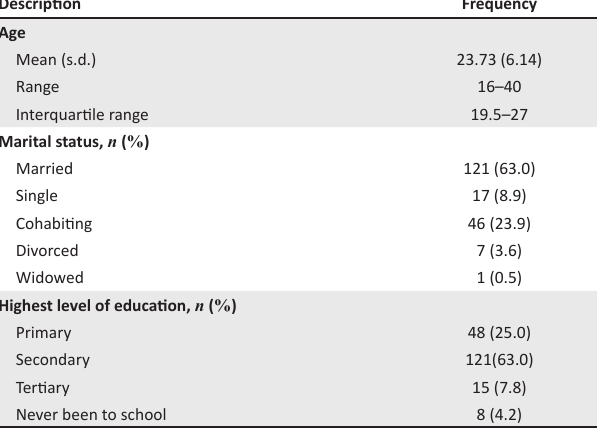
TABLE 1: Demographic characteristics of study participants ( N =